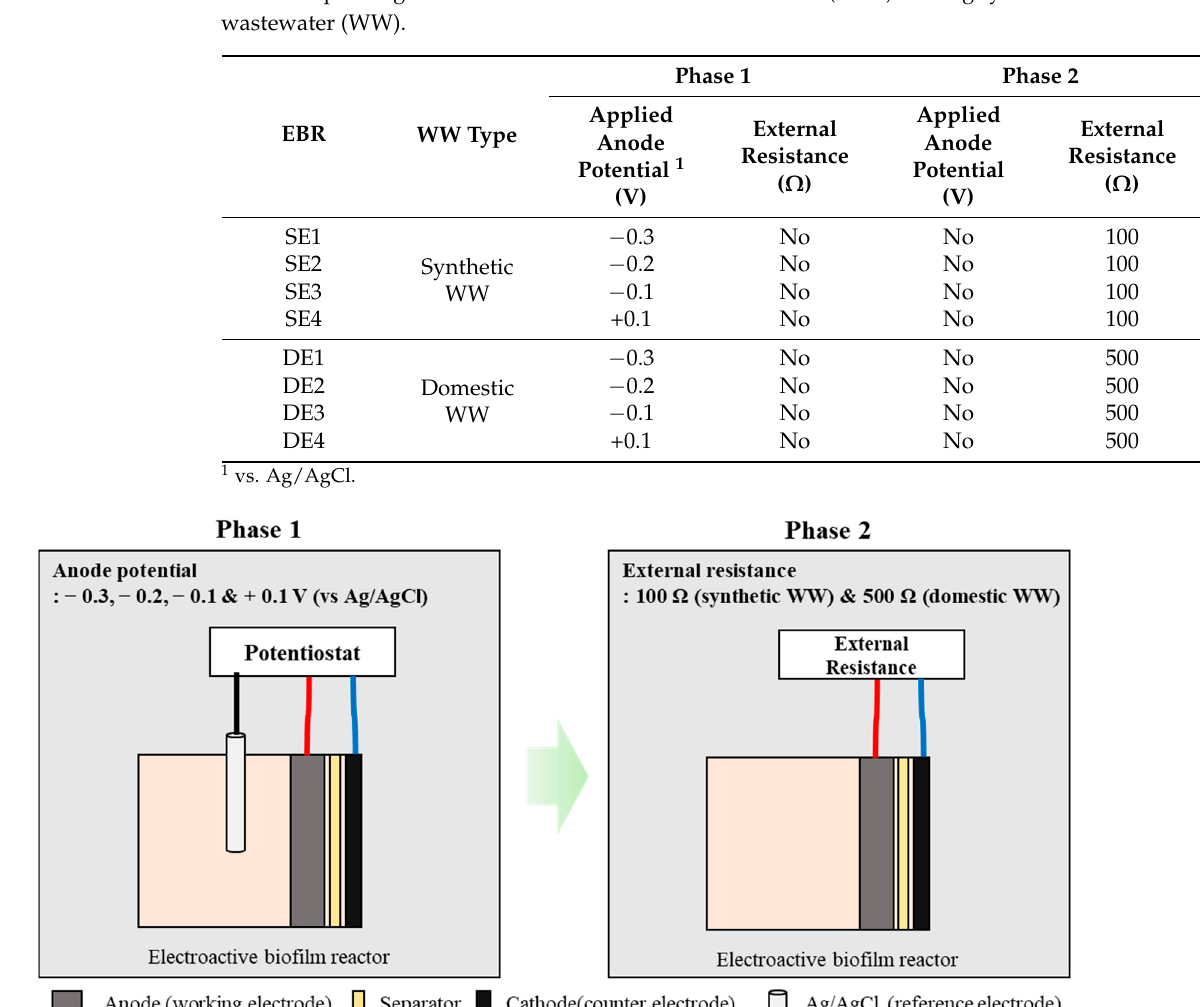
Figure 1. Experimental configuration of this study.